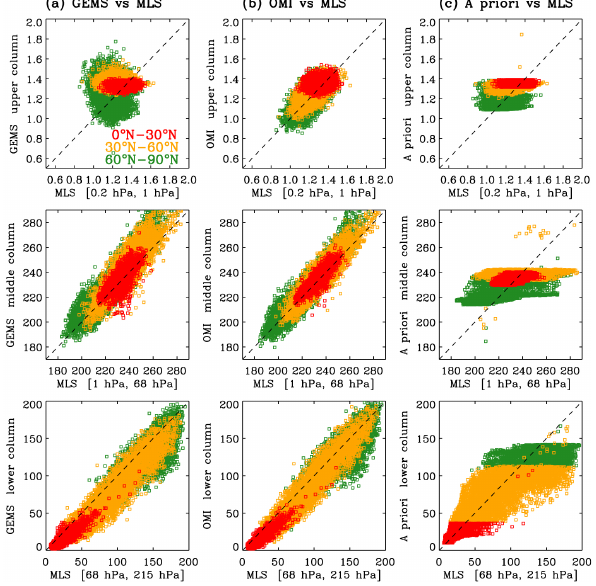
Fig. 5. Scatter plots of (a) GEMS versus MLS, (b) OMI versus MLS, and (c) a priori versus MLS for partial column ozone at three vertical layers between 0 ◦ N and 90 ◦ N for April 2006. The layers are bounded by 0.2, 1, 68, and 215hPa. Color coding for different latitude bins is indicated in the legend on the top left panel. Dashed lines are unit